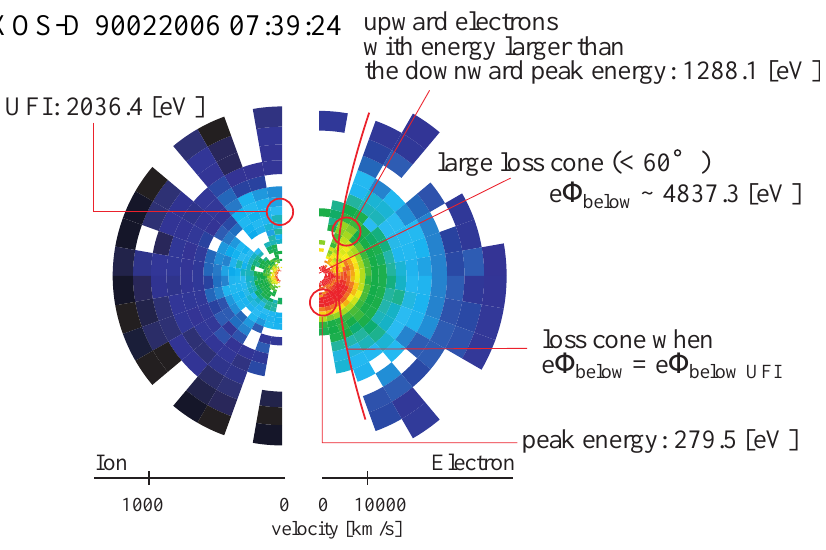
Fig. 13. Distribution functions of electrons and ions observed by Akebono. The format is the same as panel (a) of Fig. 11. The electron loss cone is extremely large, which indicates a potential difference much larger than that estimated by the UFI’s peak energy. Upgoing high-energy electrons with larger energy than that of the downward peak energy are also